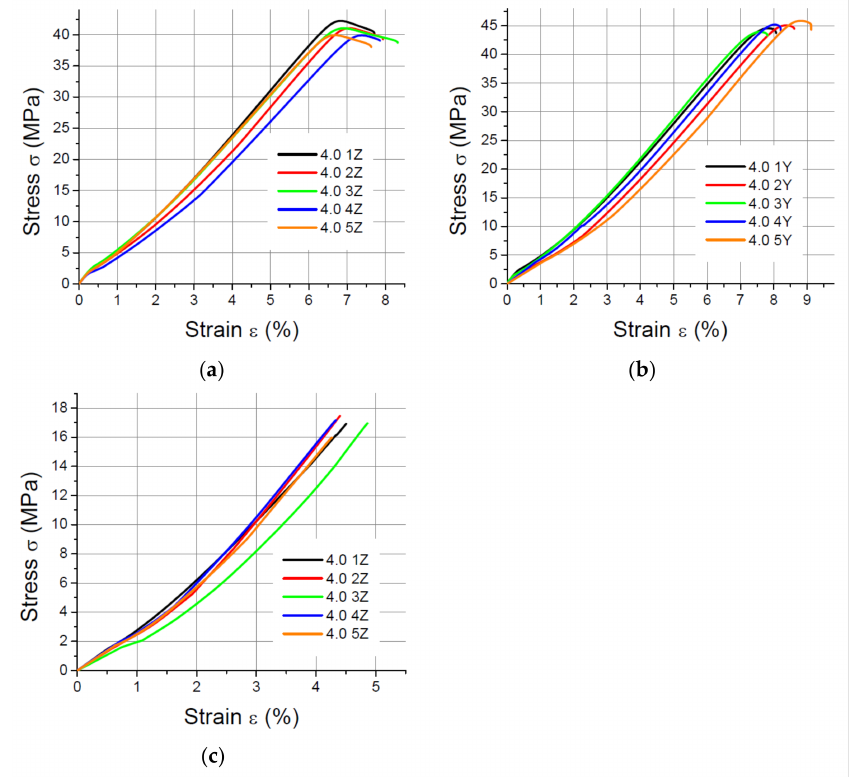
Figure 7. Tensile test results for 4 mm thick specimens made of PLA printed in ( a ) the X orientation; ( b ) the Y orientation; ( c ) the Z